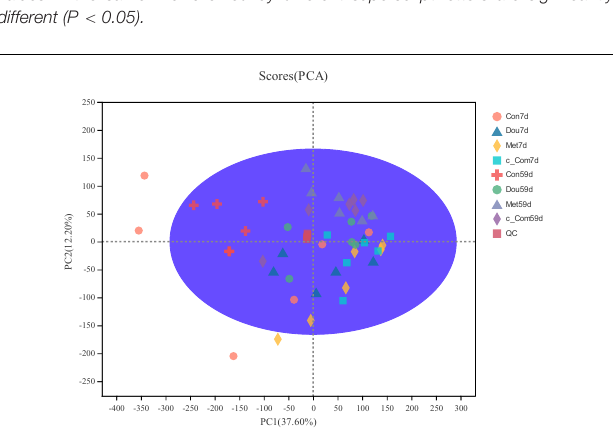
on 7th day were dispersed among samples, while c-Com on 7th day, Con on 59th day, Dou on 59th day, Met on 59th day, and c-Com on 59th day groups had more concentrated sample